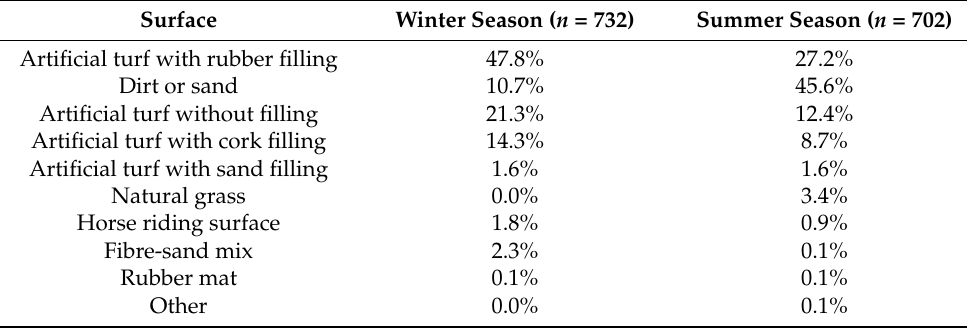
Table 3. Main surfaces used in agility training and competitions.